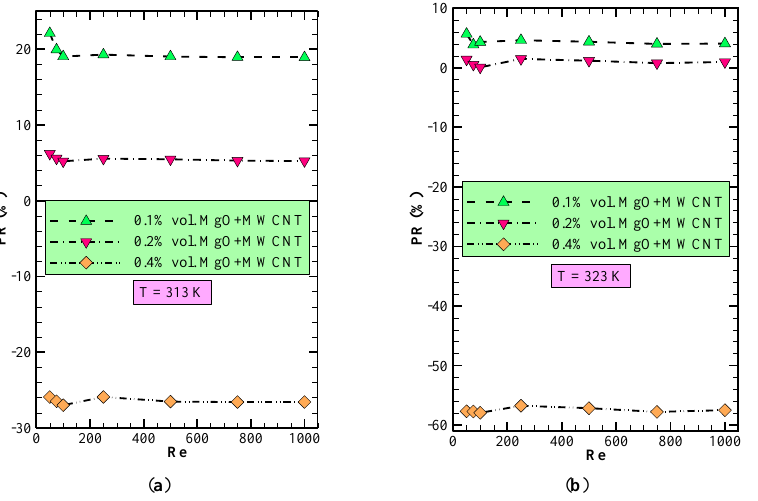
Figure 15. Effects of HNF with different VF on pressure reduction for different Re and inlet temper- atures ( a ) T = 313 K and ( b ) T = 323 K.